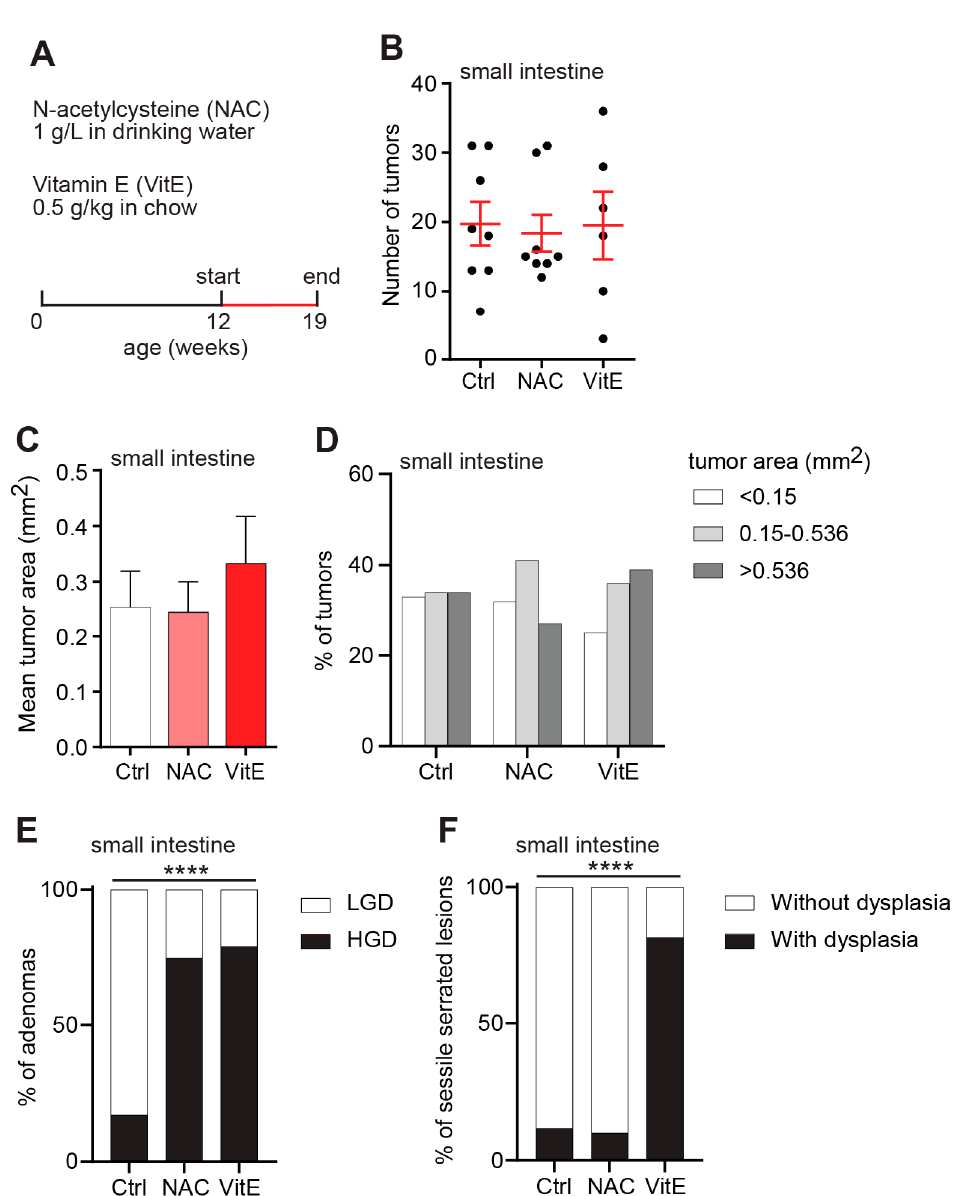
Figure 3. NAC or vitamin-E treatment increases the histopathological grade of advanced tumors . ( A ) Schematic of the study design. NAC or VitE were supplemented in the drinking water or chow diet of APC Min/+ mice from 12 until 19 weeks of age. ( B ) Tumor numbers in one sagittal section of the small intestine of 19-week-old APC Min/+ mice ( n = 8 Ctrl, 8 NAC, 6 VitE). ( C , D ) The geometric mean area ( C ) and size distribution ( D ) of individual tumors in the small intestines of 19-week-old APC Min/+ mice ( n = 117–158 tumors, error bars indicate 95% confidence intervals). ( E , F ) Distribution graphs showing the percentage of adenomas with HGD or LGD (E), or sessile serrated lesions (SSLs) with or without dysplasia ( F ), in the small intestines of 19-week-old APC Min/+ mice ( n = 47–67 adenomas, 10-17 SSLs). HGD, high-grade dysplasia; LGD, low-grade dysplasia. **** p < 0.0001.